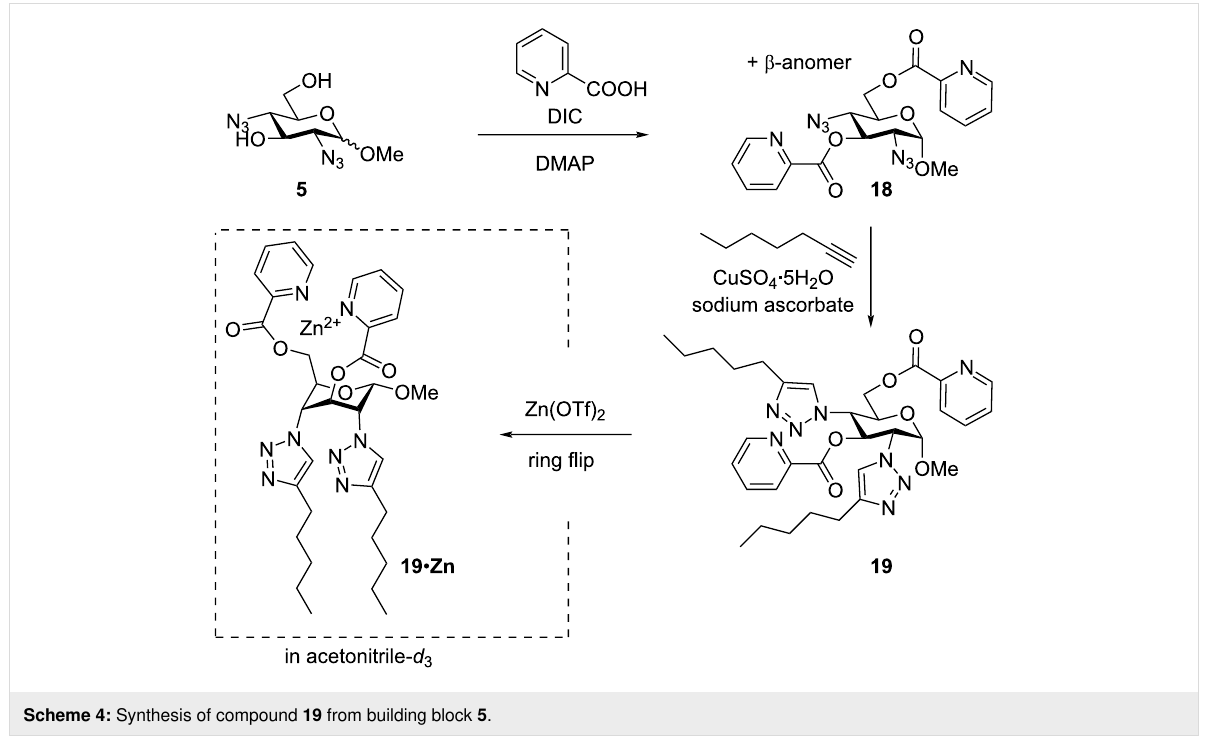
Scheme 4: Synthesis of compound 19 from building block 5 .